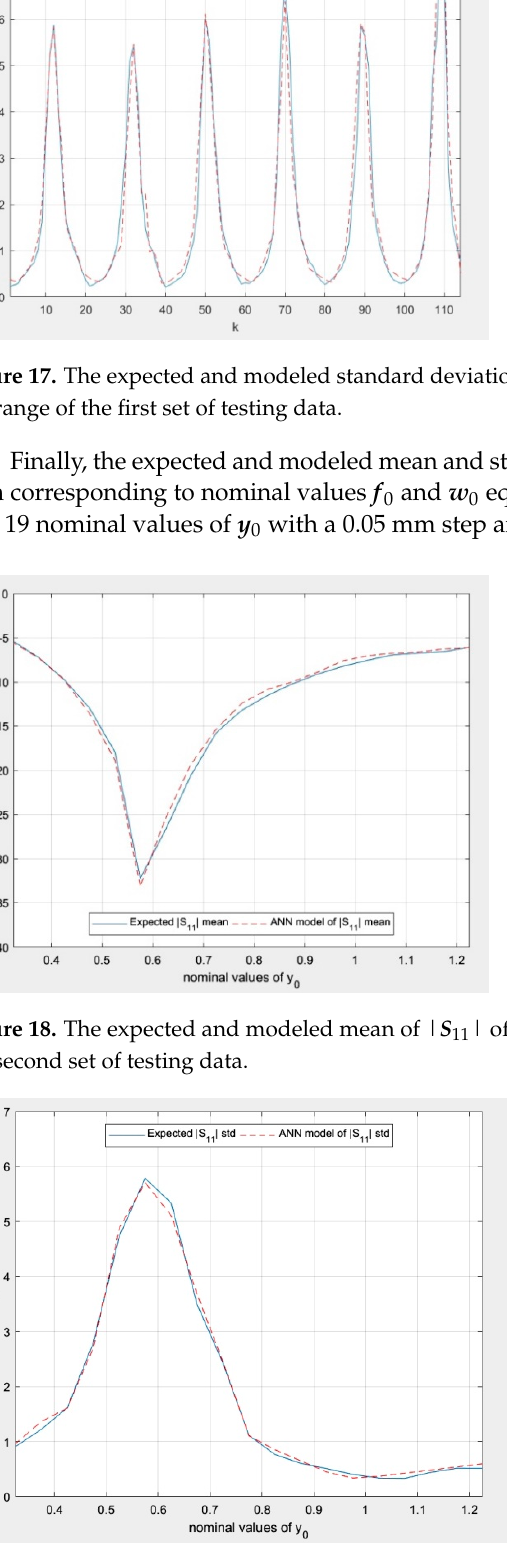
Figure 19. The expected and modeled standard deviation of | S 11 | of an ordinary patch antenna for the range of the second set of testing data.